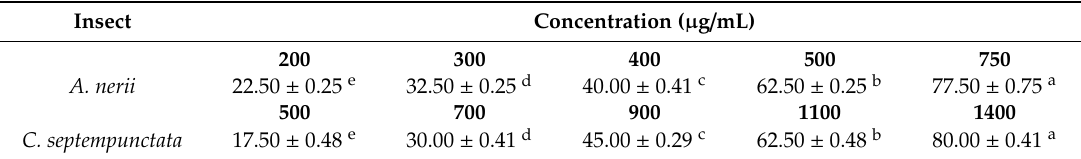
Table 4. Mean mortality ± SE of the adults of Aphis nerii and Coccinella septempunctata exposed to the di ff erent concentration of Satureja intermedia essential oil after 24 h.